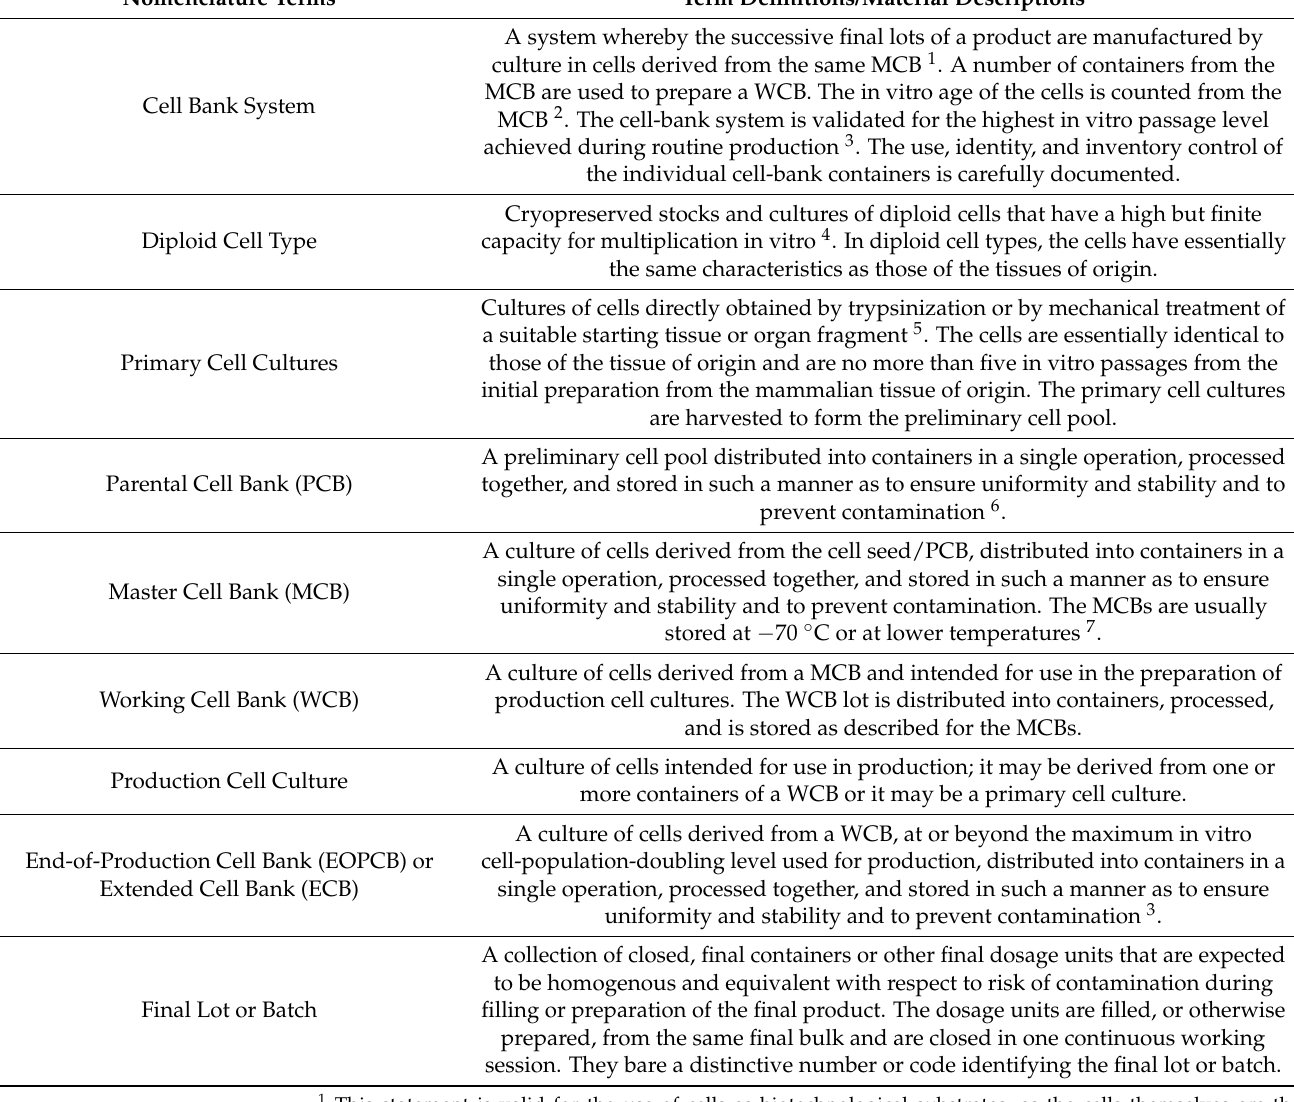
Table 3. Nomenclature definition in relation to multi-tiered cell banking of primary progenitor cells in biotechnology, as set forth in Ph. Eur. general chapters 5.2.1. and 5.2.3. and/or under the Swiss progenitor-cell-transplantation program [1,65,67]. API, active pharmaceutical ingredient;